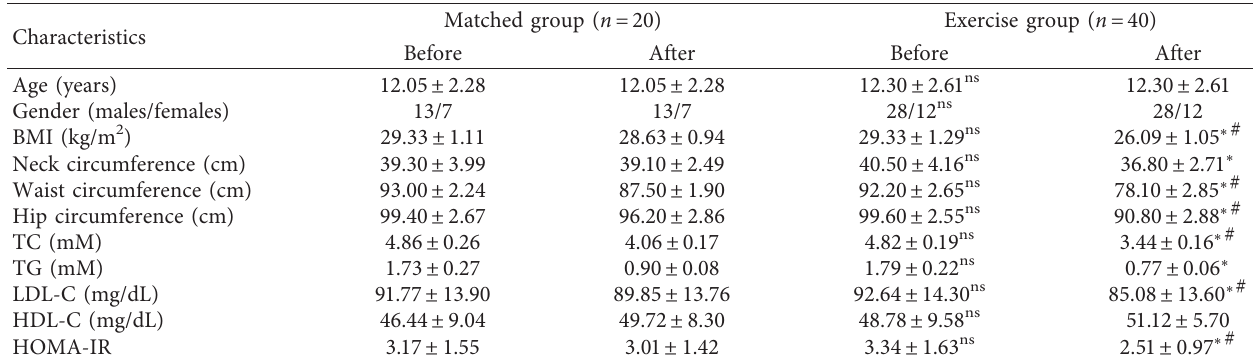
Table 1: Comparisons of the baseline characteristics of obese children and adolescents before and after intervention.